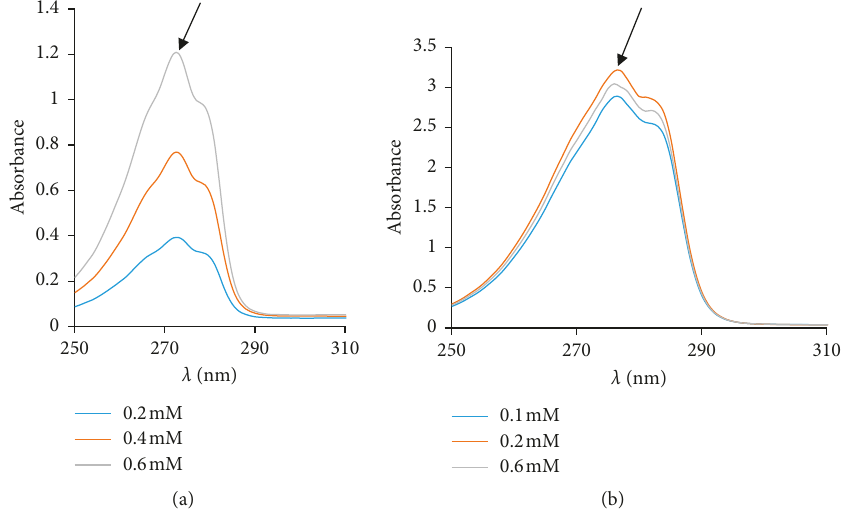
Figure 2: UV absorption spectra of phenol in (a) methanol, and (b) DMSO with arrows indicating the λ